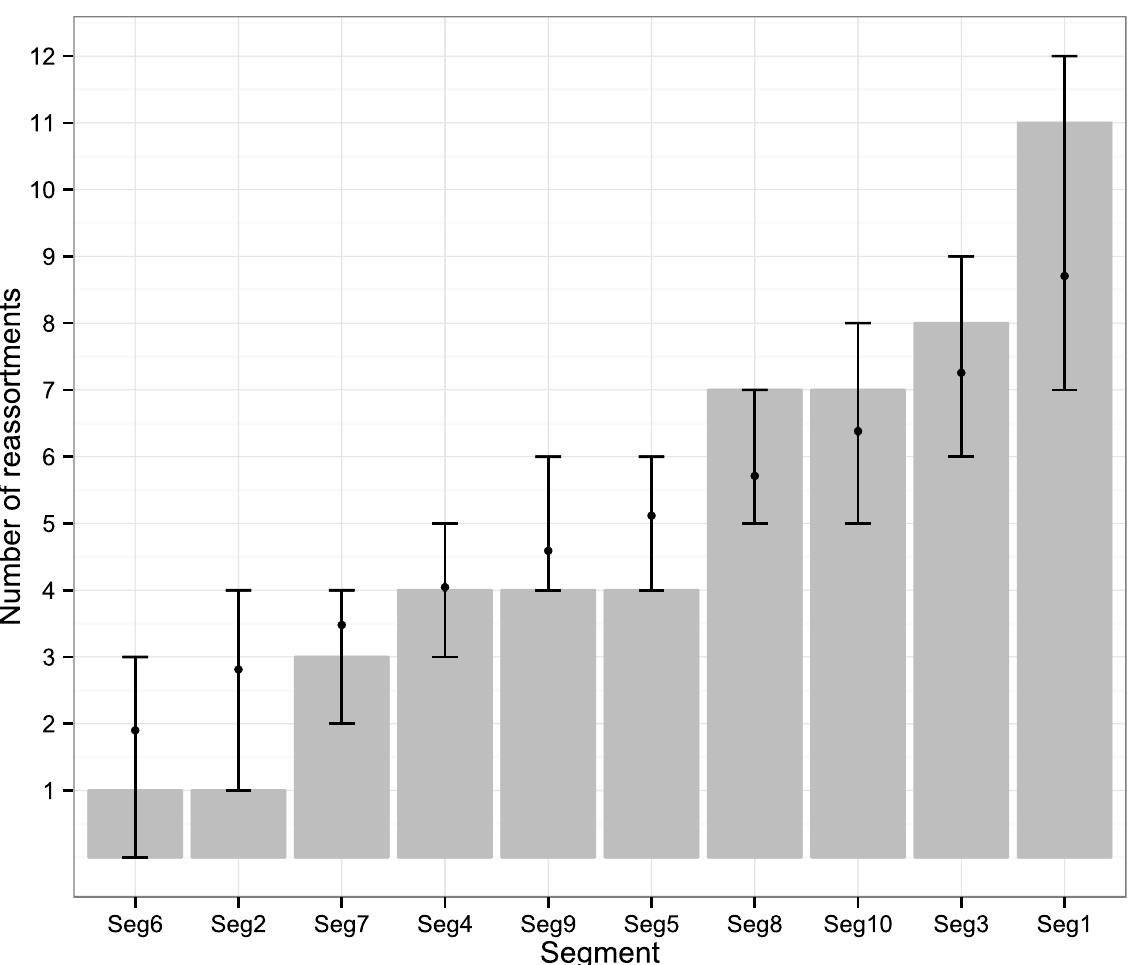
Fig 3. Number of inferred reassortment events per BTV segment in Europe since 1955. All frequencies estimated relative to Seg-2; for Seg-2 the phylogeny of Seg-6 was used as the reference point instead. Bars represent expected values based on 10,000 simulations.